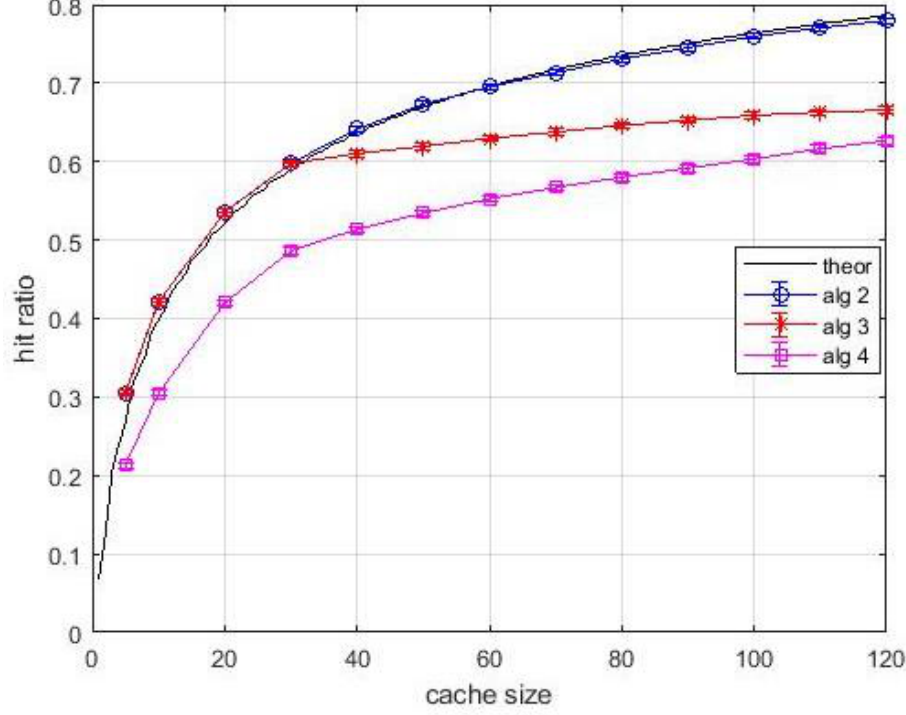
Figure 15. Hit ratio, case 4, N =